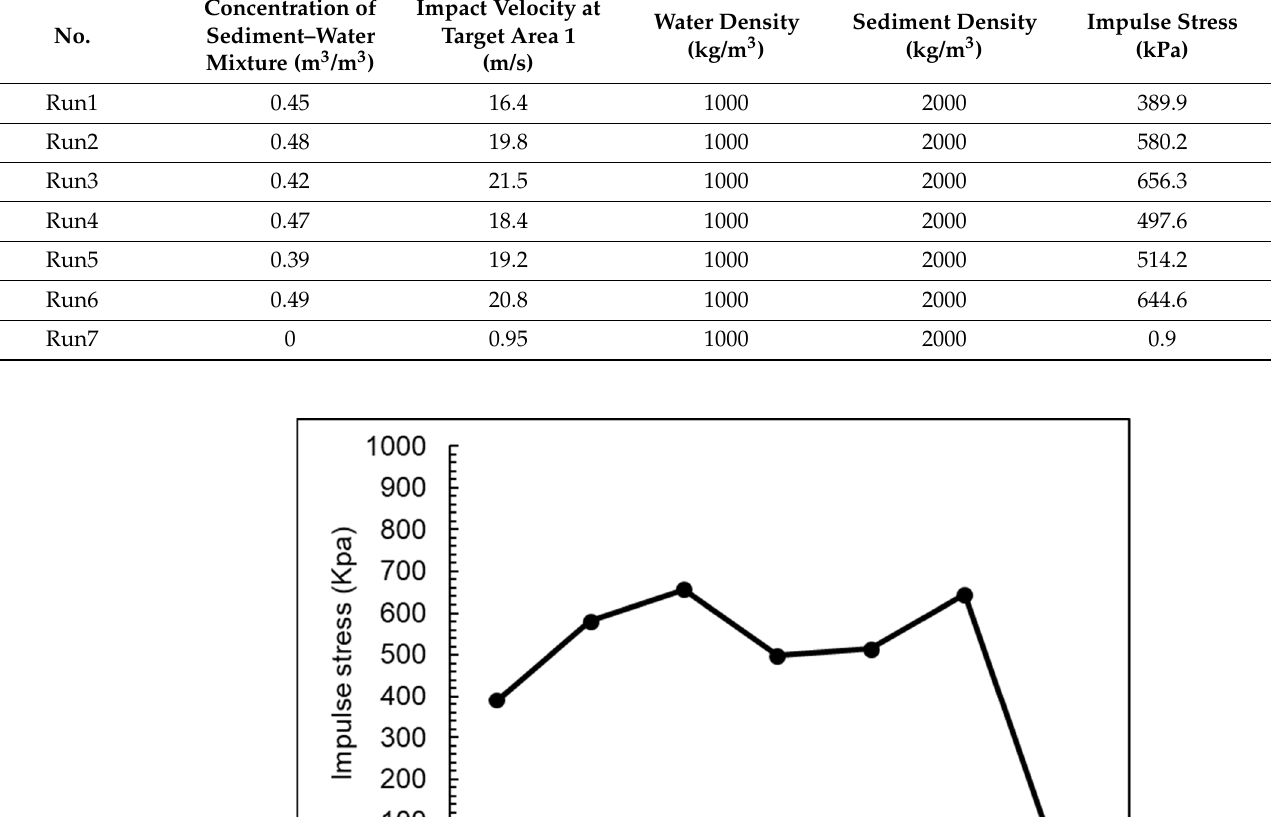
Table 5. Parameters of impulse stress at the target area 1.